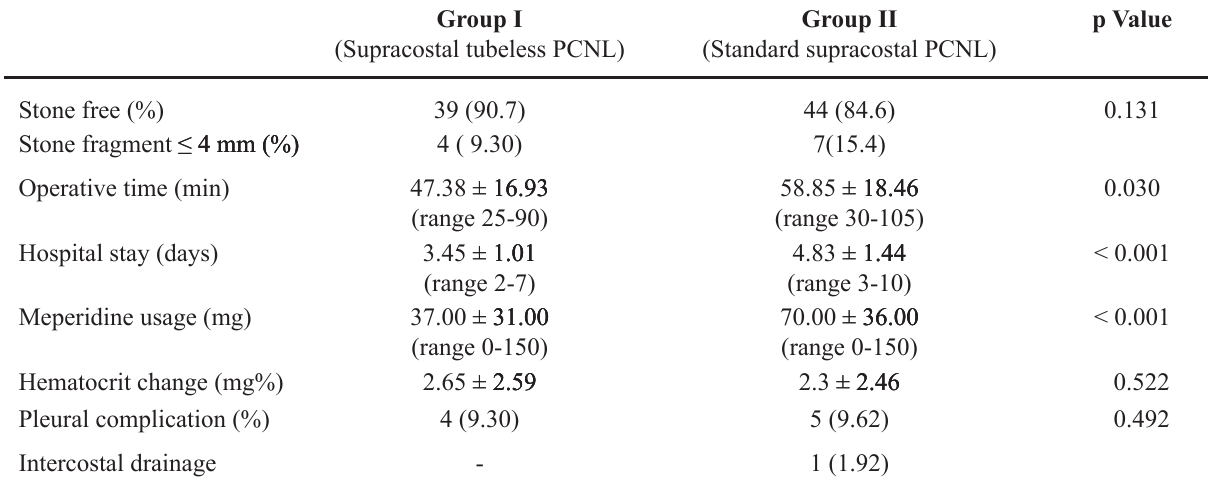
Table 3 – Results and